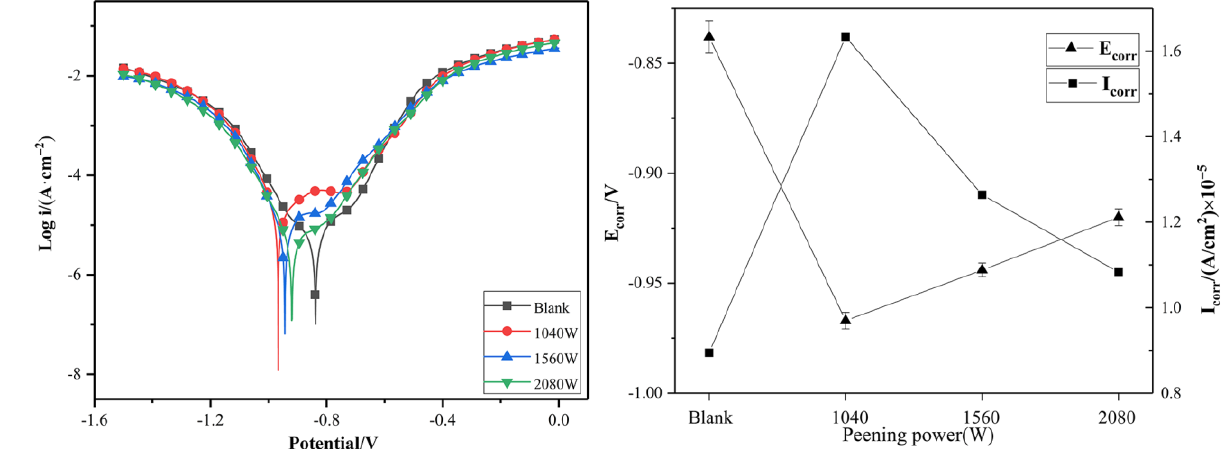
Figure 12. Electrochemical test polarization curves and line plot of the corrosion potential and cor- rosion current of samples with different levels of USP power.